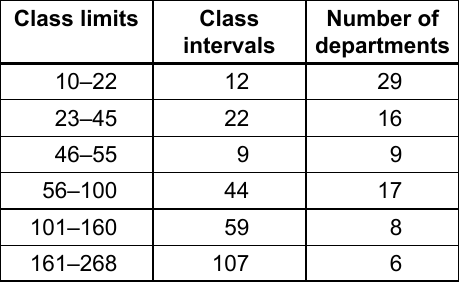
Tab. 3. Class selection using the natural breaks